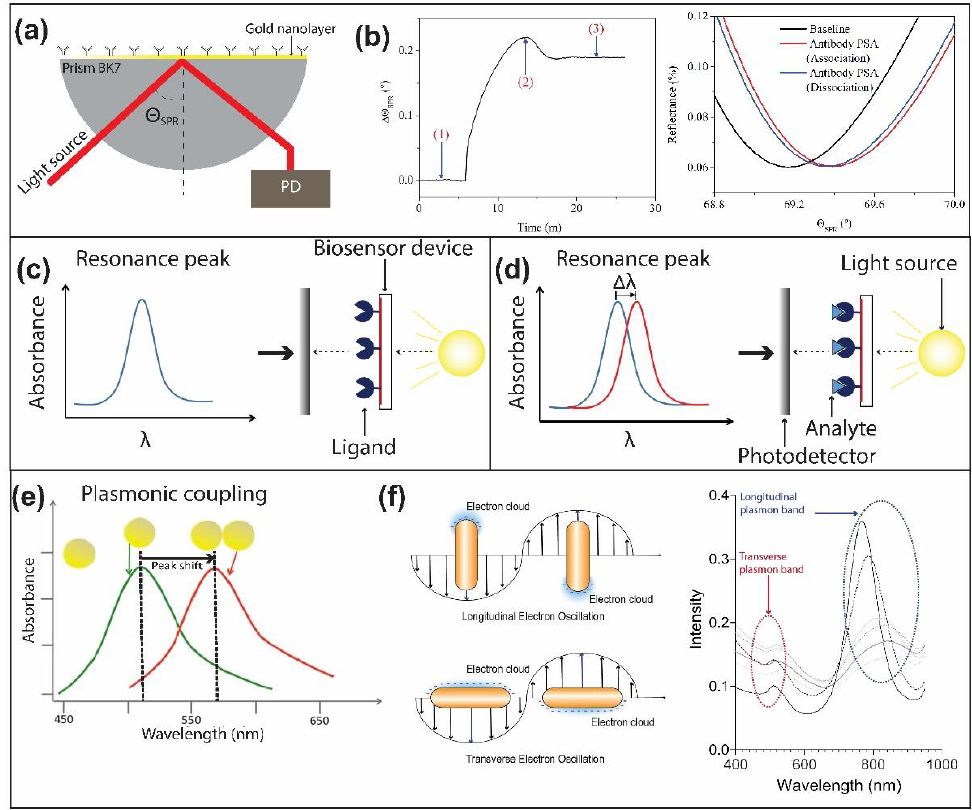
Figure 10. ( a ) Scheme of a traditional SPR system. ( b ) Behavioral description of the reflectance angle as a function of time and the Reflectance curve as a function of the variation baseline-antibody PSA (association)-antibody PSA (dissociation). The figures in ( c , d ) show the behavior of the resonance curve of a localized surface plasmon resonance (LSPR) system before and after achieving the biological recognition, respectively [123]. ( e ) Schematic demonstration of plasmonic coupling. ( f ) Resonance scheme in non-homogeneous nanoparticles, in this specific case,